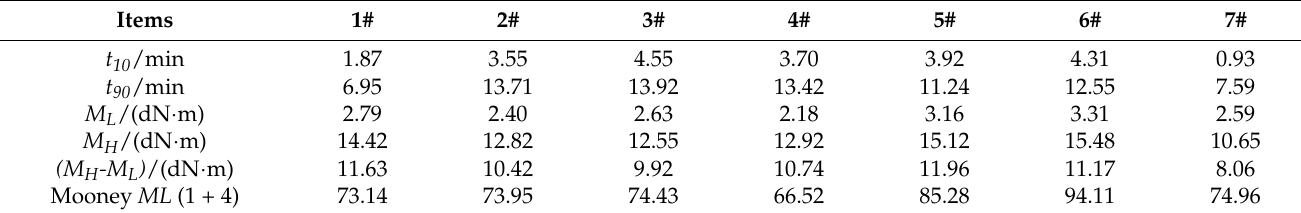
Table 3. Results data of experiments for vulcanizate properties after